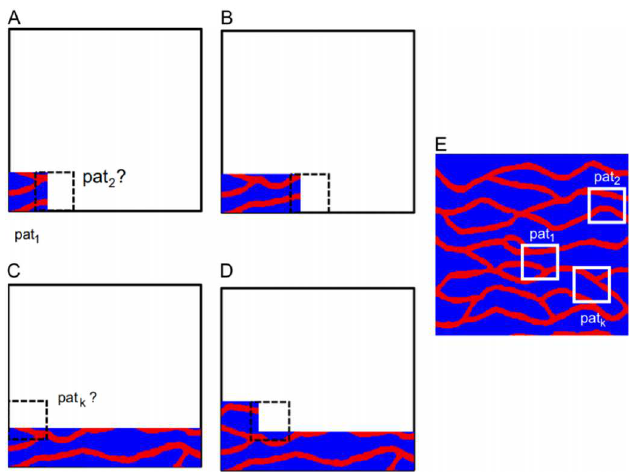
Fig. 6. Scheme of the CCSIM (courtesy of P. Tahmasebi). From A to D, the blank simulation is filled block by block, all extracted from the training image E. Each new block patched is randomly picked among a definite number of matching